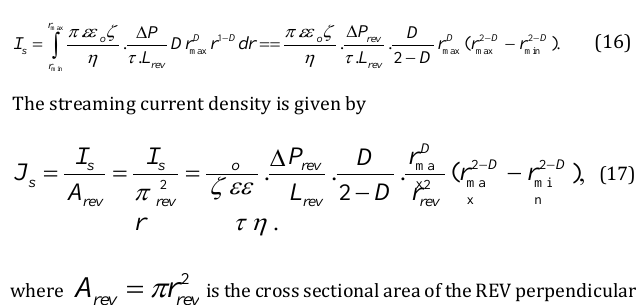
Figure 3: A poro